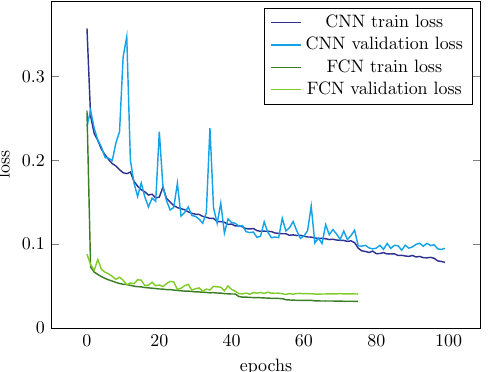
Figure 9. Train and validation losses of both